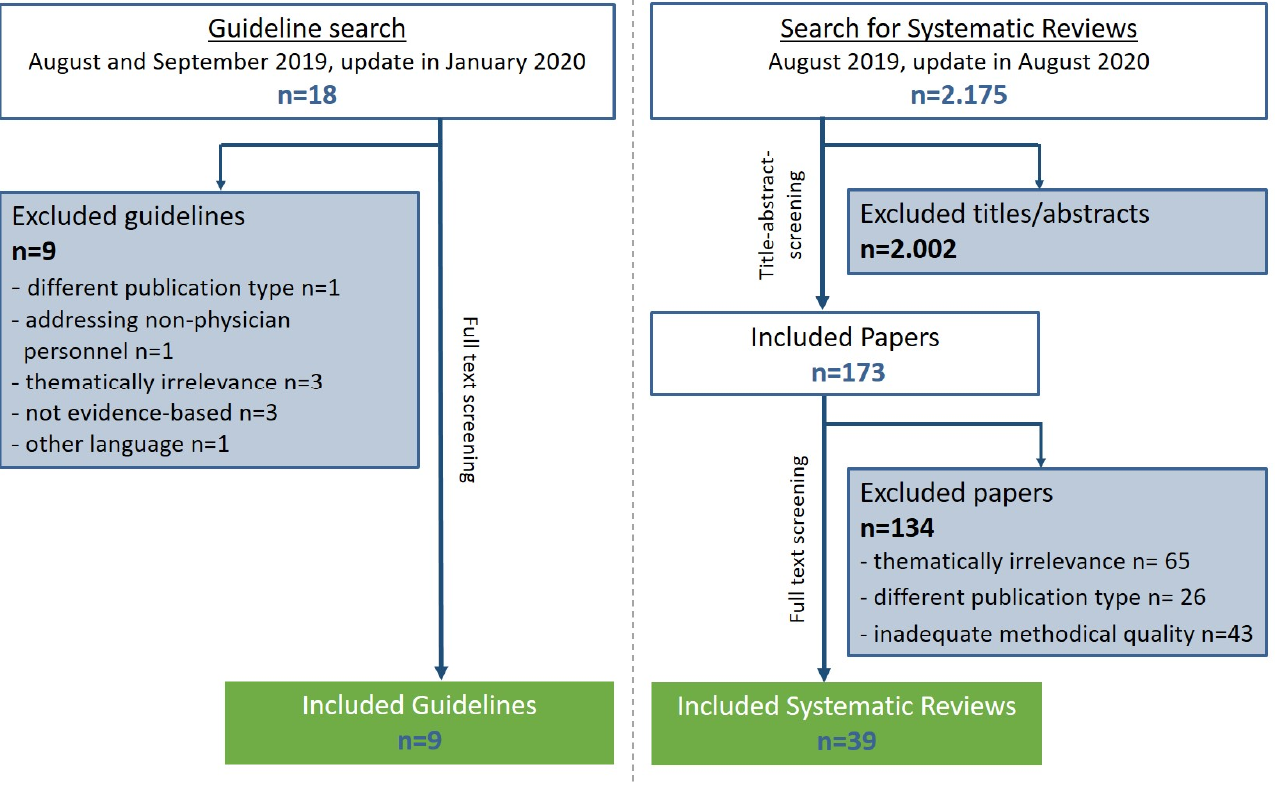
Figure 1. Flow chart of the systematic literature search for clinical practice guidelines and the systematic reviews in the context of hip OA and THA.